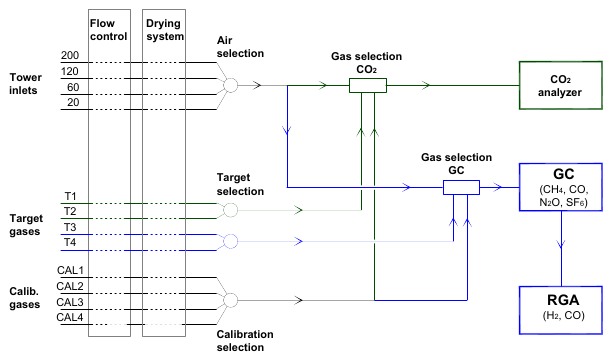
Fig. 2. Principle (simplified) scheme of the trace gases measure- ment system at